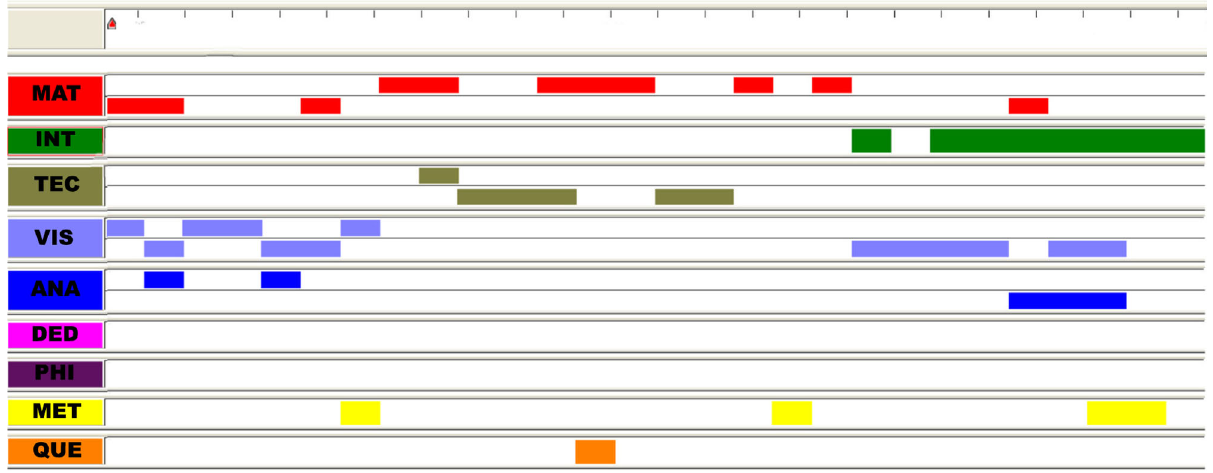
FIG. 8. Timeline of the electric field of an infinite wire problem